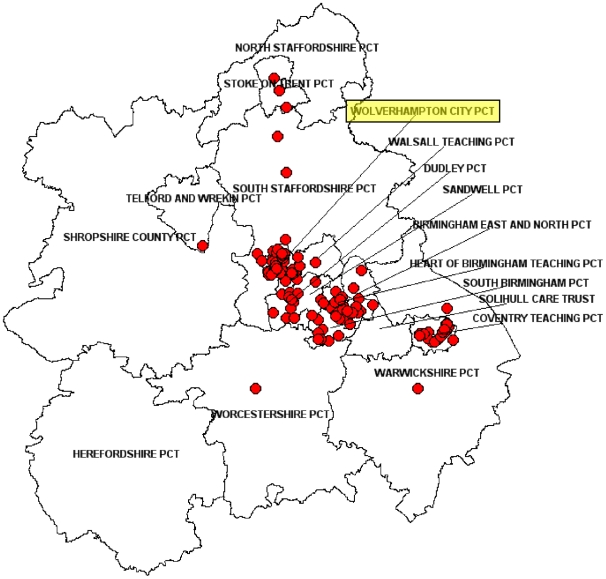
Geographical mapping of cases with the Mercian strain in the West Midlands between 2004 and 2008.Primary Care Trusts (PCTs) are regional NHS organizations in England that provide primary and community care. The city of Wolverhampton where the focused epidemiological investigation was undertaken is highlighted in yellow. The postcode map was produced under license by ©Crown Copyright and database right 2010. Ordnance Survey License 100016969/100022432.